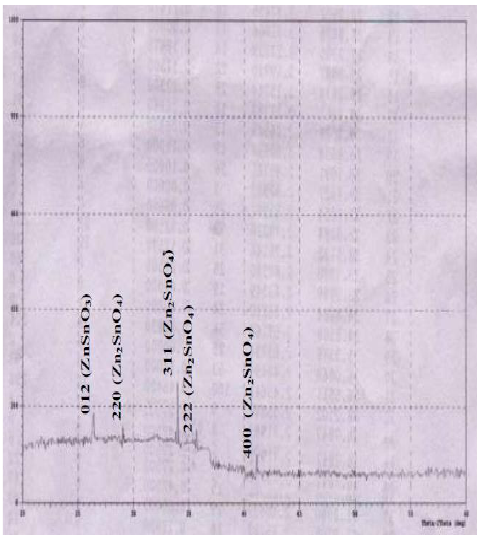
Fig. 3: XRD Spectra of Z